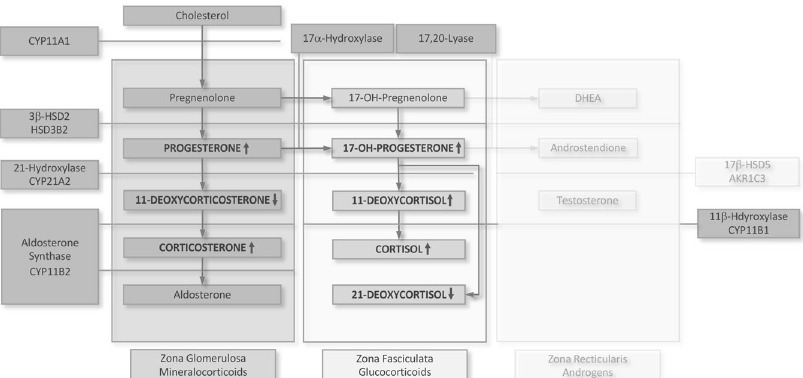
Fig. 1 Pathways of steroid hormone synthesis in the adrenal glands, including the involved enzymes and the genes coding these enzymes (boxes surrounding the three adrenal zones) adapted from Han, Walker [52]. Steroid hormone levels altered in adolescent MDD compared to the reference cohort are printed in all capitals and bold type. As androgens were not studied, their synthesis is grayed out. CYP cytochrome P450, HSD hydroxysteroid dehydrogenase, AKR1C3 aldo-keto reductase family 1 member